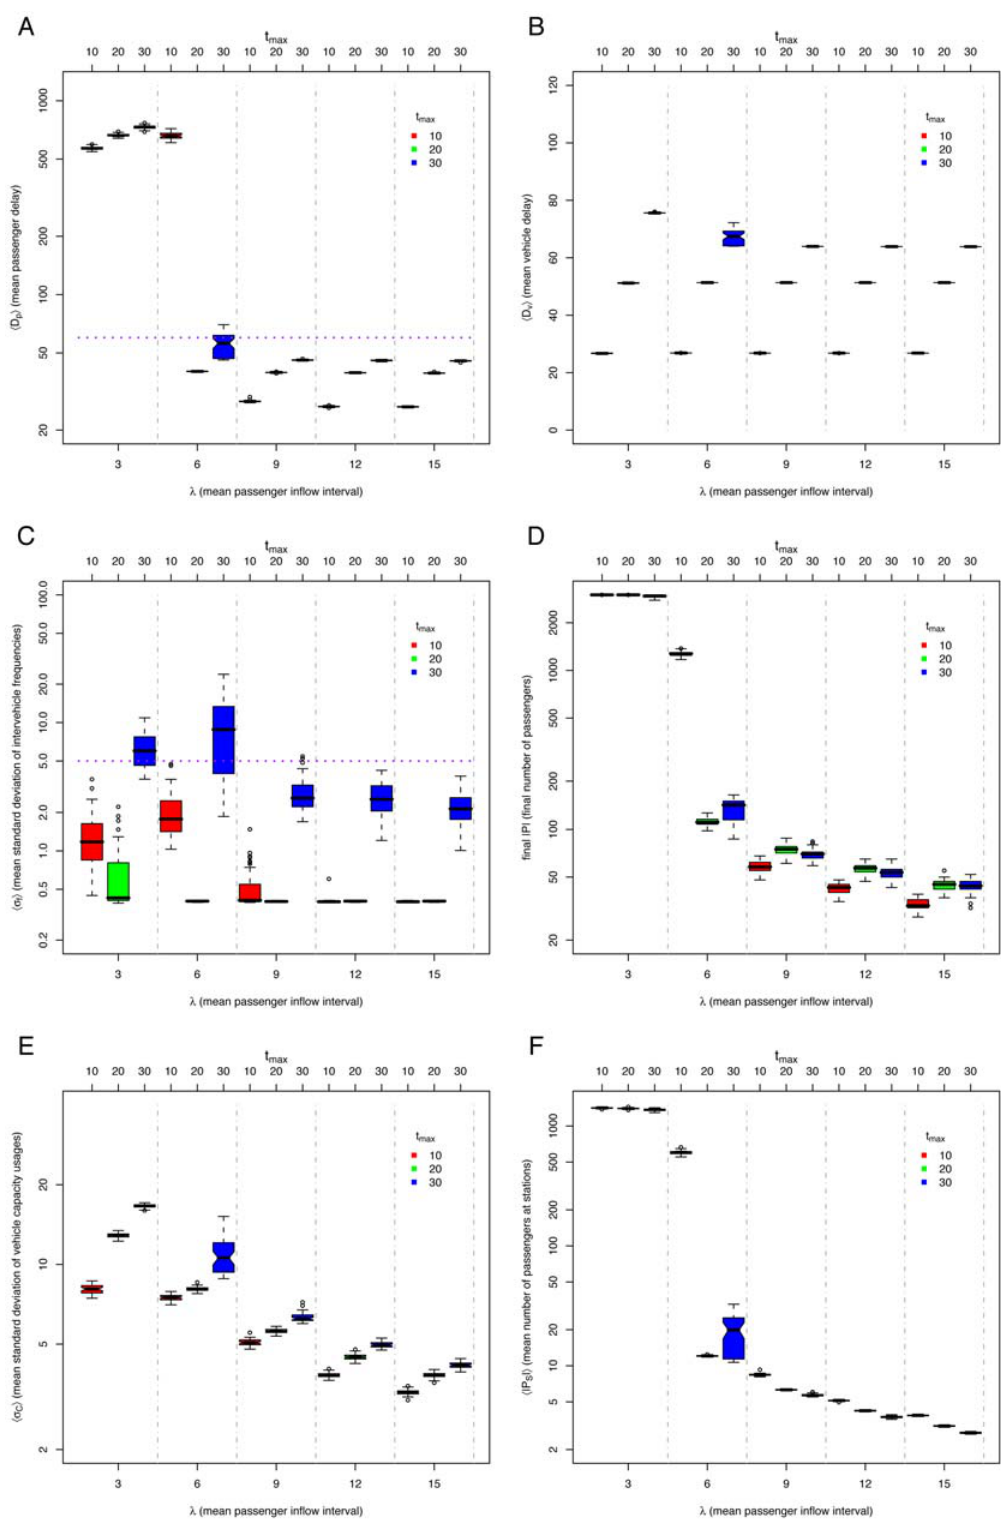
Figure 6. Simulation results for maximum method , varying mean passenger inflow intervals l (lower x axis, separated by vertical dashed lines), different maximum station waiting times t max (upper x axis, also indicated by color of boxes), and number of vehicles V j j ~ 5 : (A) mean passenger delay S D p T (data above horizontal dotted line indicates poor system performance), (B) mean vehicle delay S D v T , (C) mean standard deviation of intervehicle frequencies S s f T (data above horizontal dotted line implies unstable headways), (D) final number of passengers P j j , (E) mean standard deviation of vehicle capacity usage S s C T , and (F) mean number of passengers at stations S P s j j T .